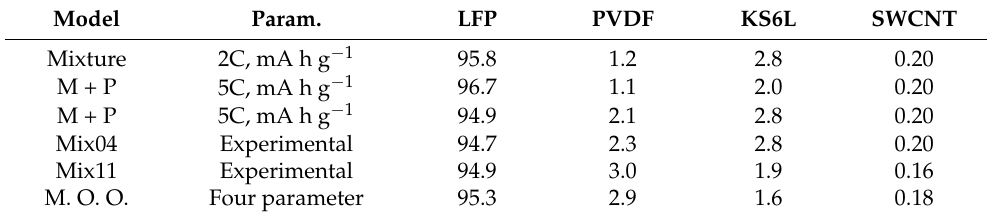
Table 3. Model recommendations (component wt%).